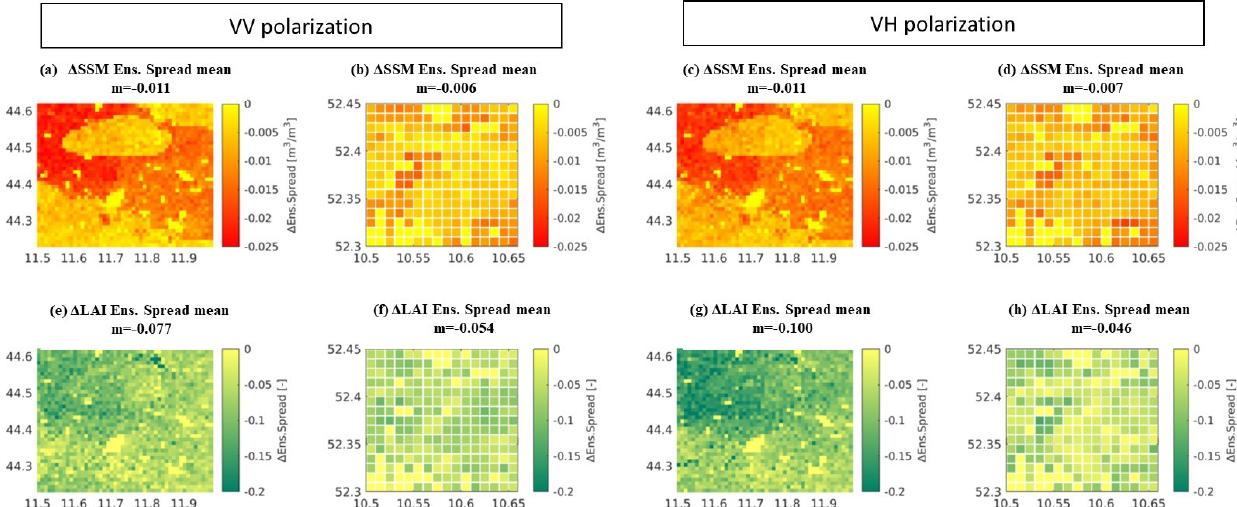
Figure 3. Maps of the difference in time–mean ensemble spread between the DA and OL runs for (a–d) SSM ( (cid:49) SSM ens. spread) and (e–h) LAI ( (cid:49) LAI ens. spread). (cid:49) SSM ens. spread after Sentinel-1 γ 0 VV DA (a) in Italy and (b) in Germany; Sentinel-1 γ 0 VH DA (c) in Italy and (d) in Germany. (e–h) Similar to (a) – (d) but for (cid:49) LAI ens. spread.m is the mean over the entire study area. The reference period